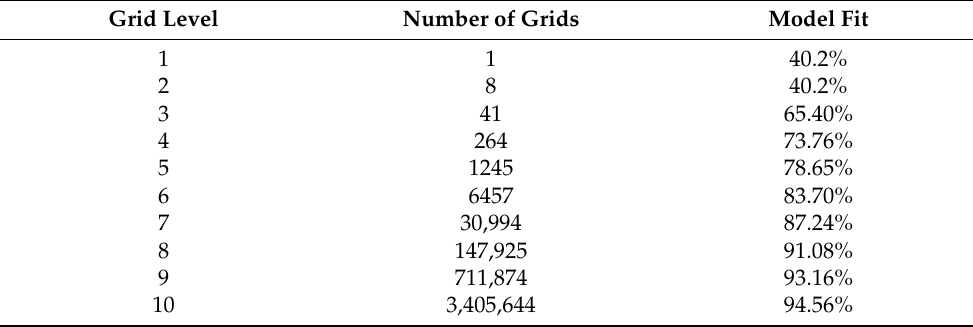
Table 1. Single-scale octree gridded